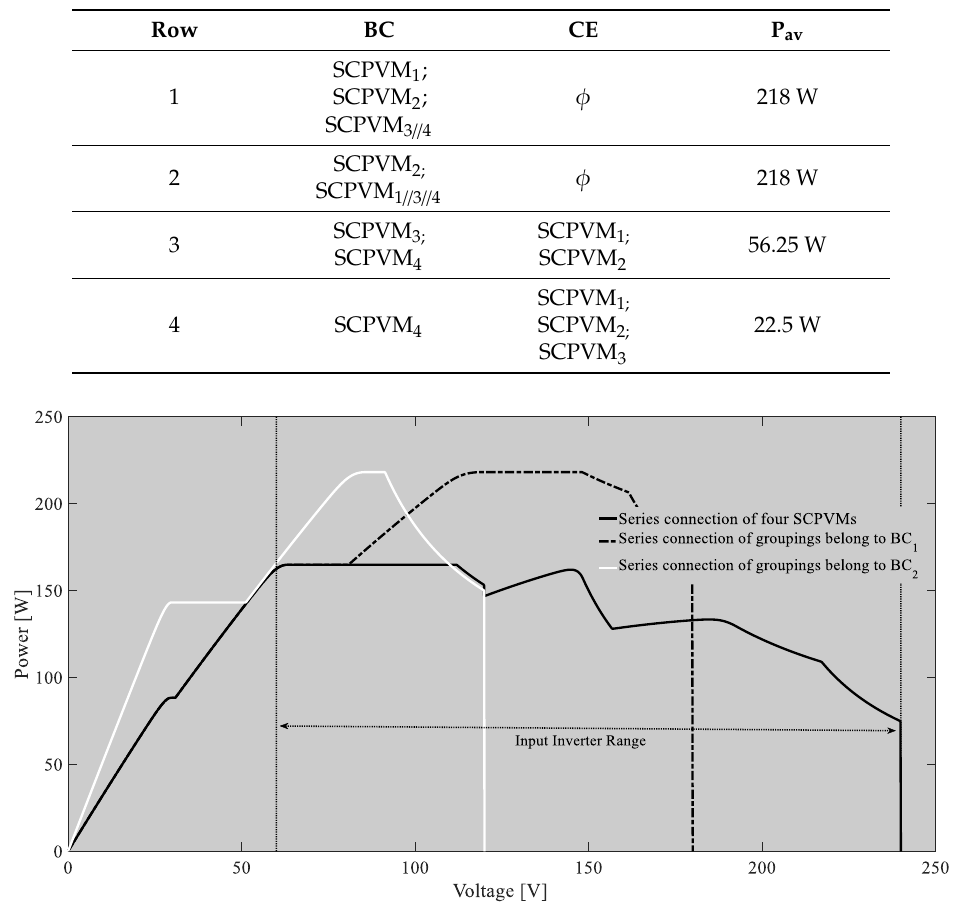
Table 5. BCs and CEs (Case II).